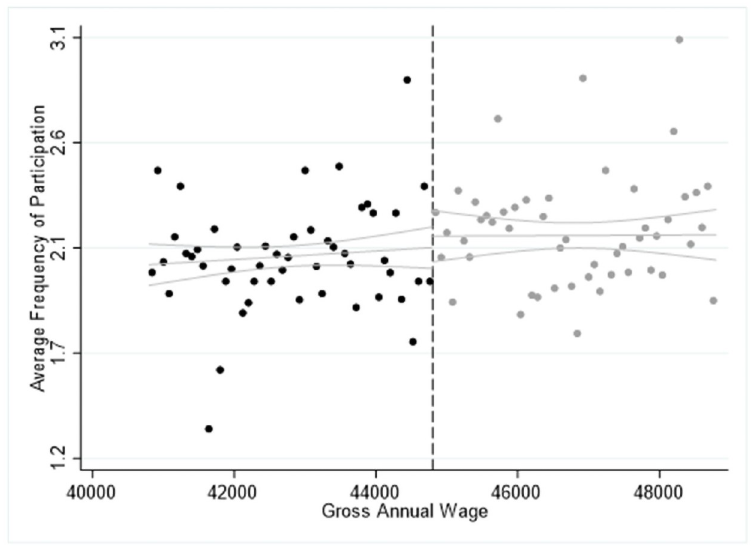
Fig 4. Sharp RDD estimates for participation in cinema and jazz/pop concerts using the salary threshold of 44,800 € and 2011 as the “Placebo” implementation year of the EU Blue Card programme.